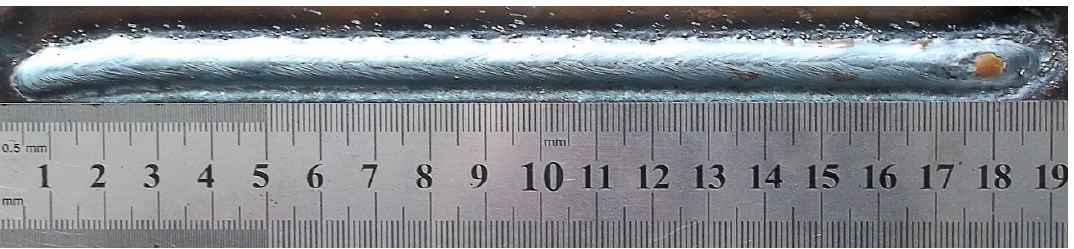
Figure 13. Pdf under the optimal parameters combination.